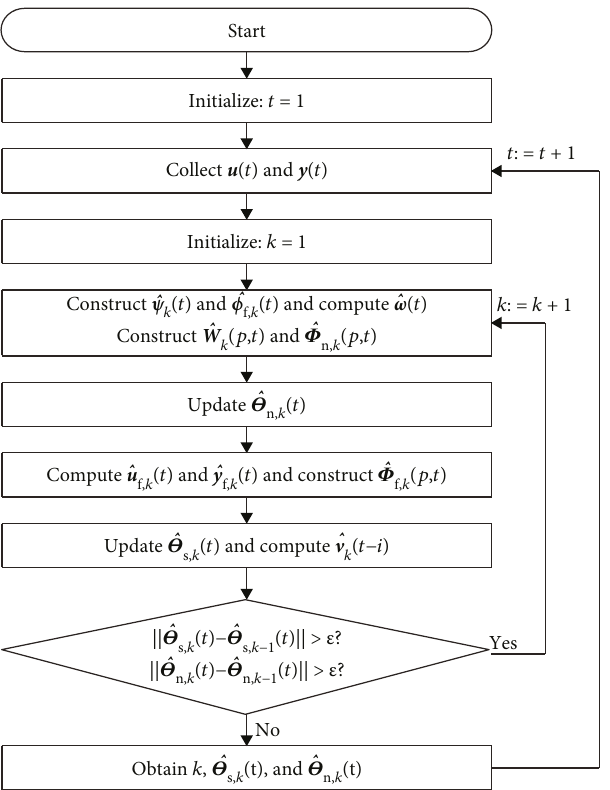
Figure 2: The fl owchart of computing the F-GI parameter estimates.